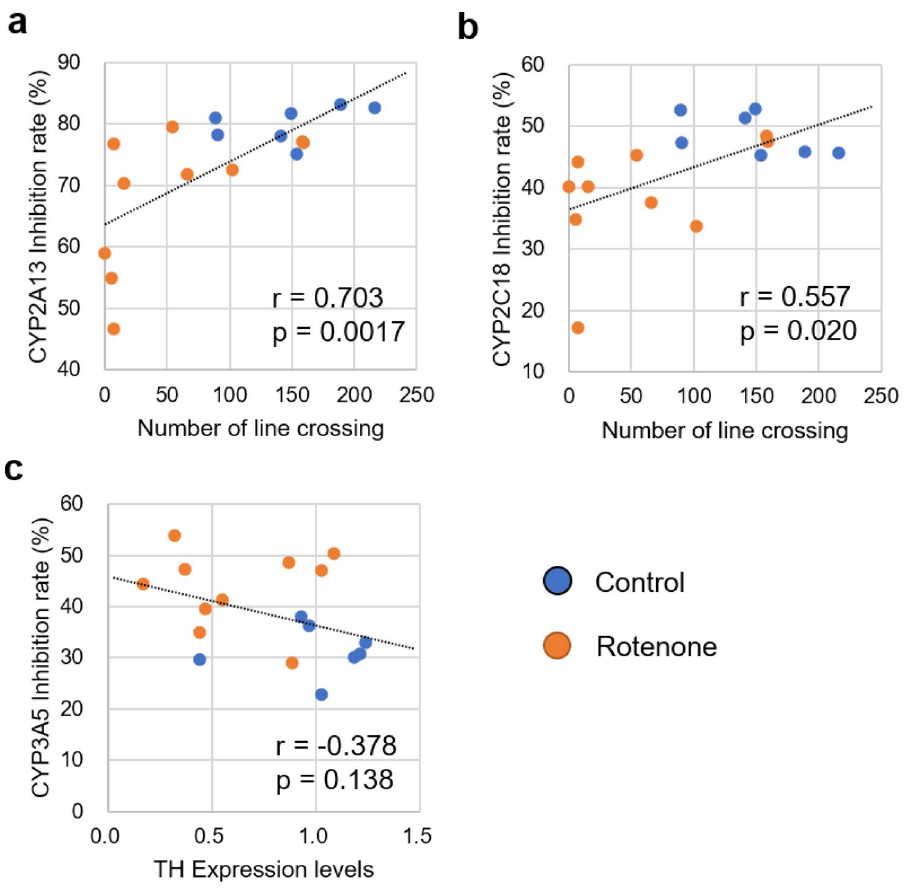
Figure 5. Correlation between the results of CYP inhibition and motor dysfunction or TH expression. ( a ) Scatter plot of the inhibition rate of CYP2A13 and number of lines crossed. ( b ) Scatter plot of the inhibition rate of CYP2C18 and number of lines crossed. ( c ) Scatter plot of the inhibition rates of CYP3A5 and TH expression levels. Pearson product-moment correlation coefficient (r) and the result of the test showing no correlation (p) are presented in each graph. CYP, cytochrome P450; TH, tyrosine